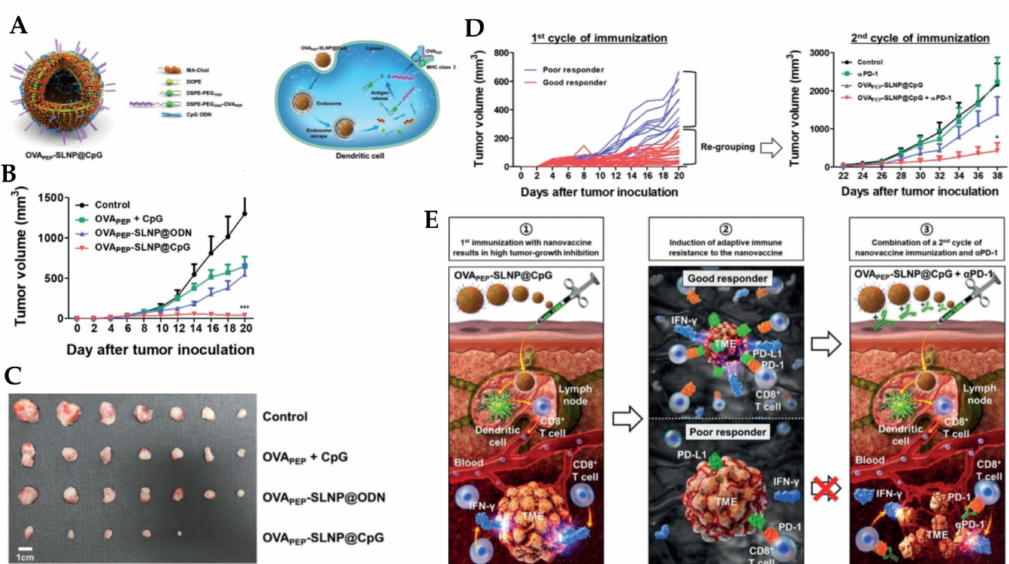
Figure 8. ( A ) Scheme and mechanism action of OVA PEP -SLNP@CpG nanovaccine, ( B )